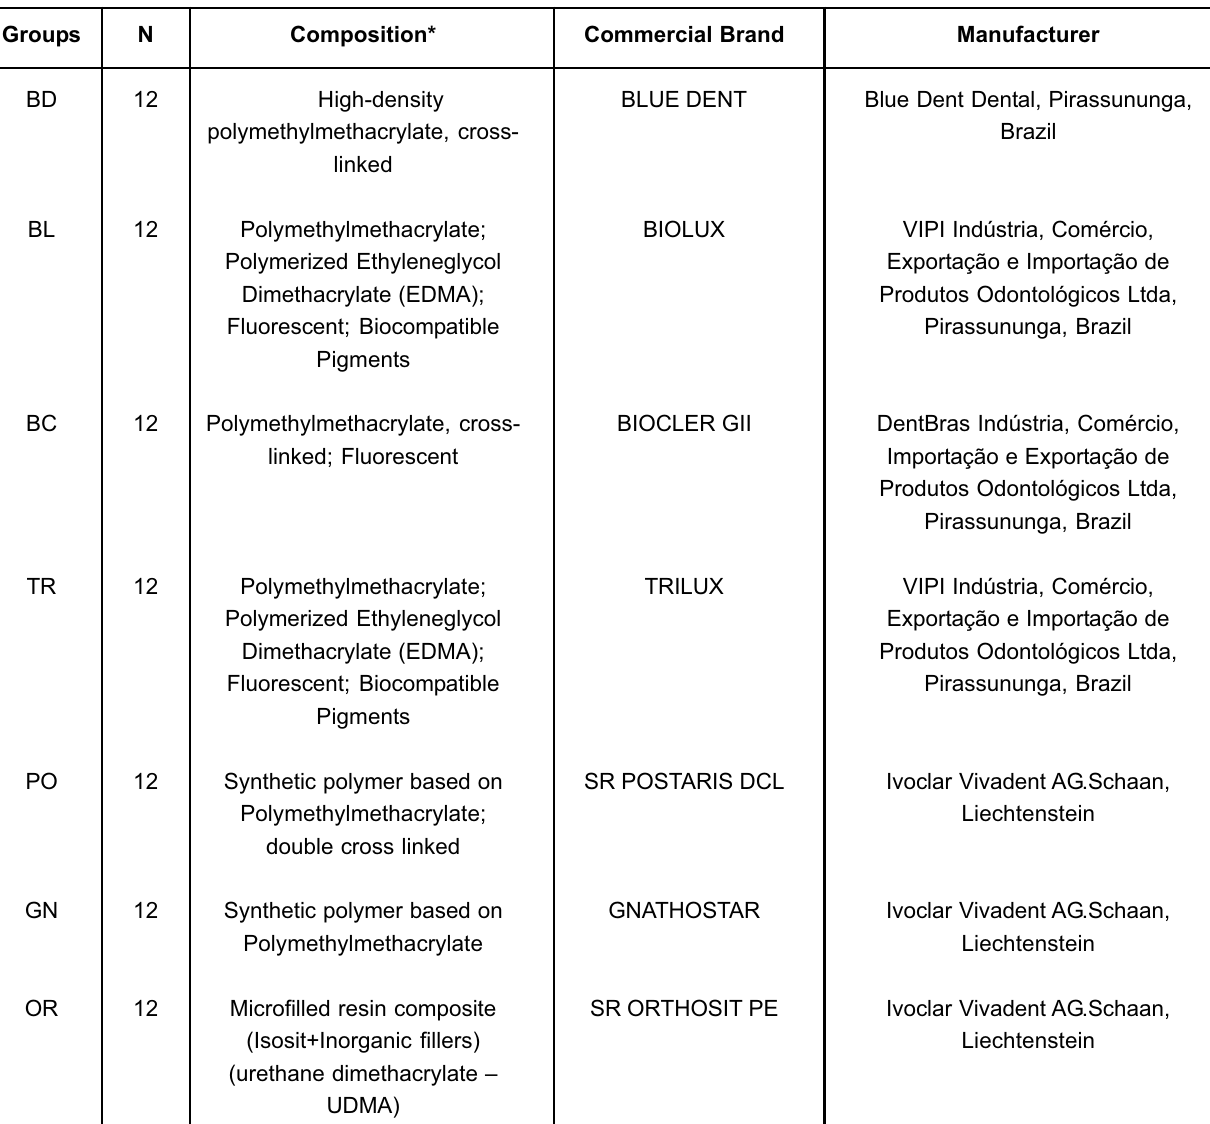
FIGURE 1- Groups of artificial teeth *Based on manufacturers’